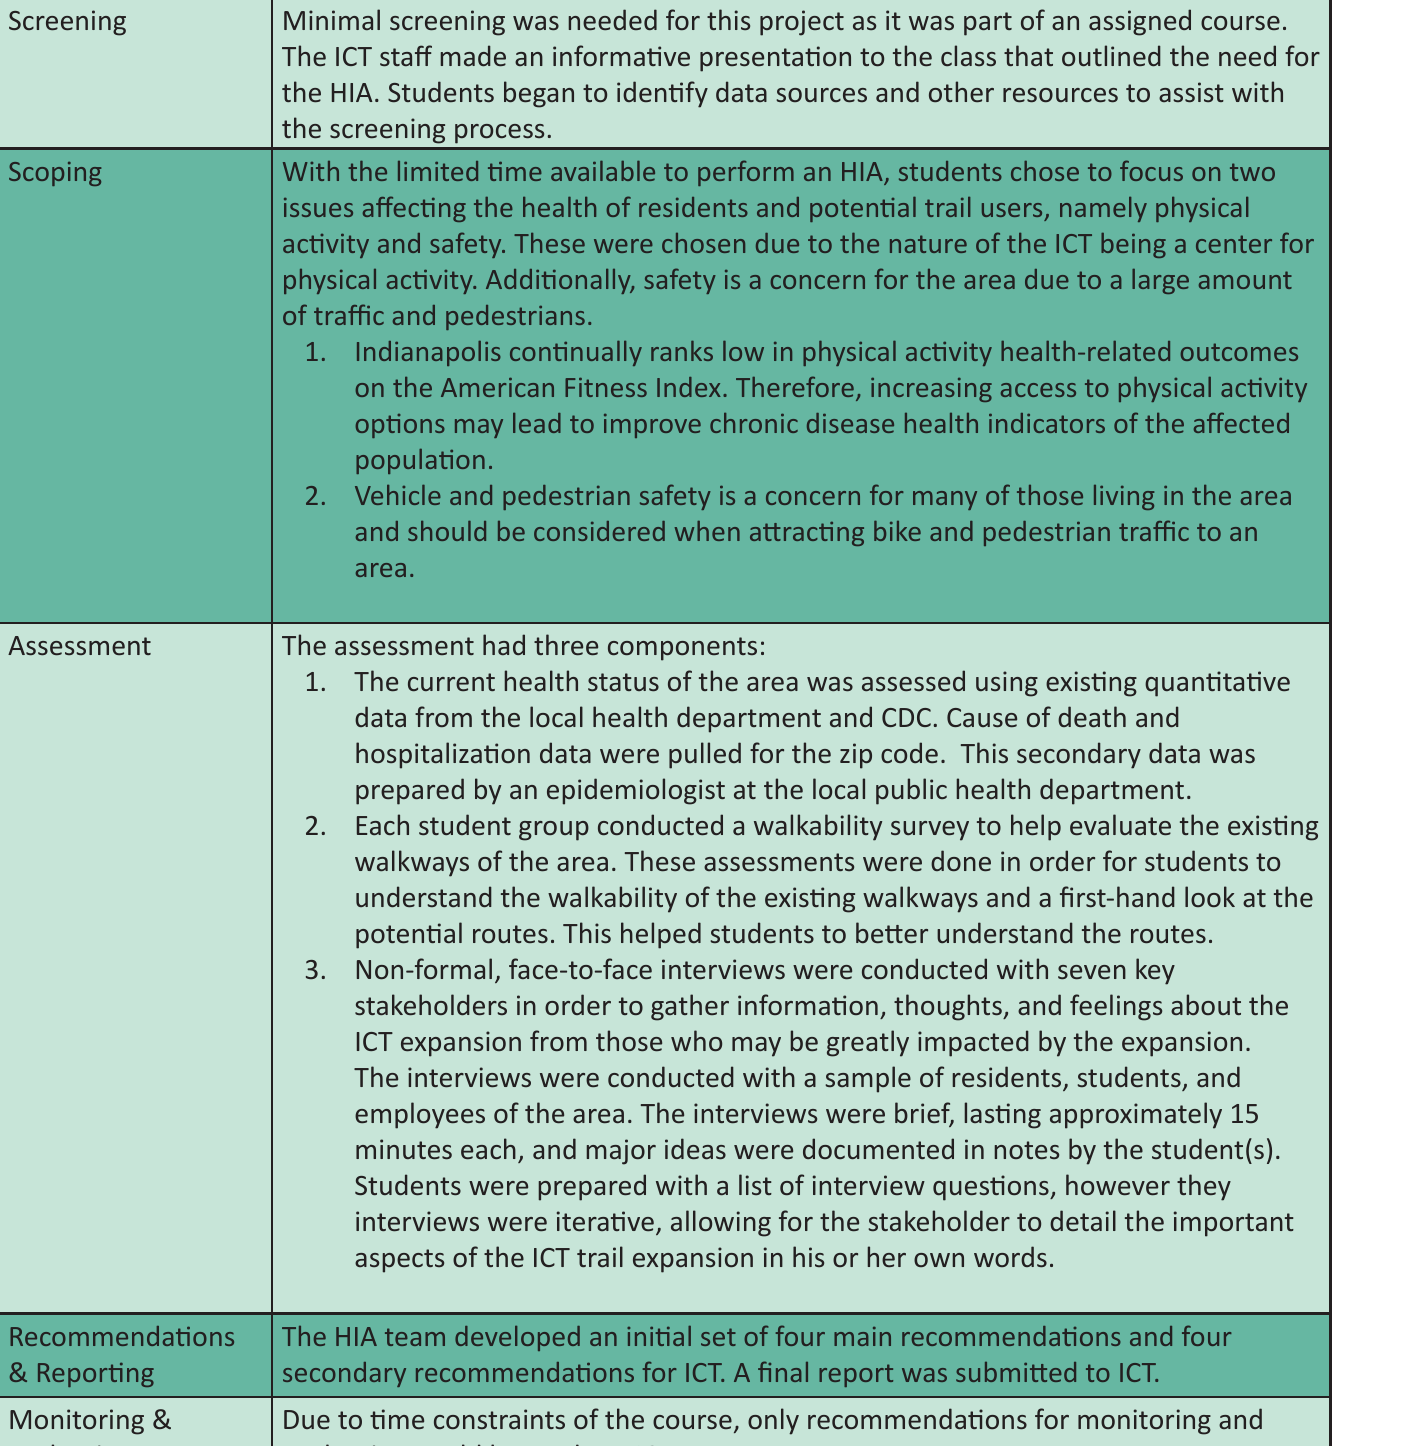
Table 2: Health Impact Assessment Steps